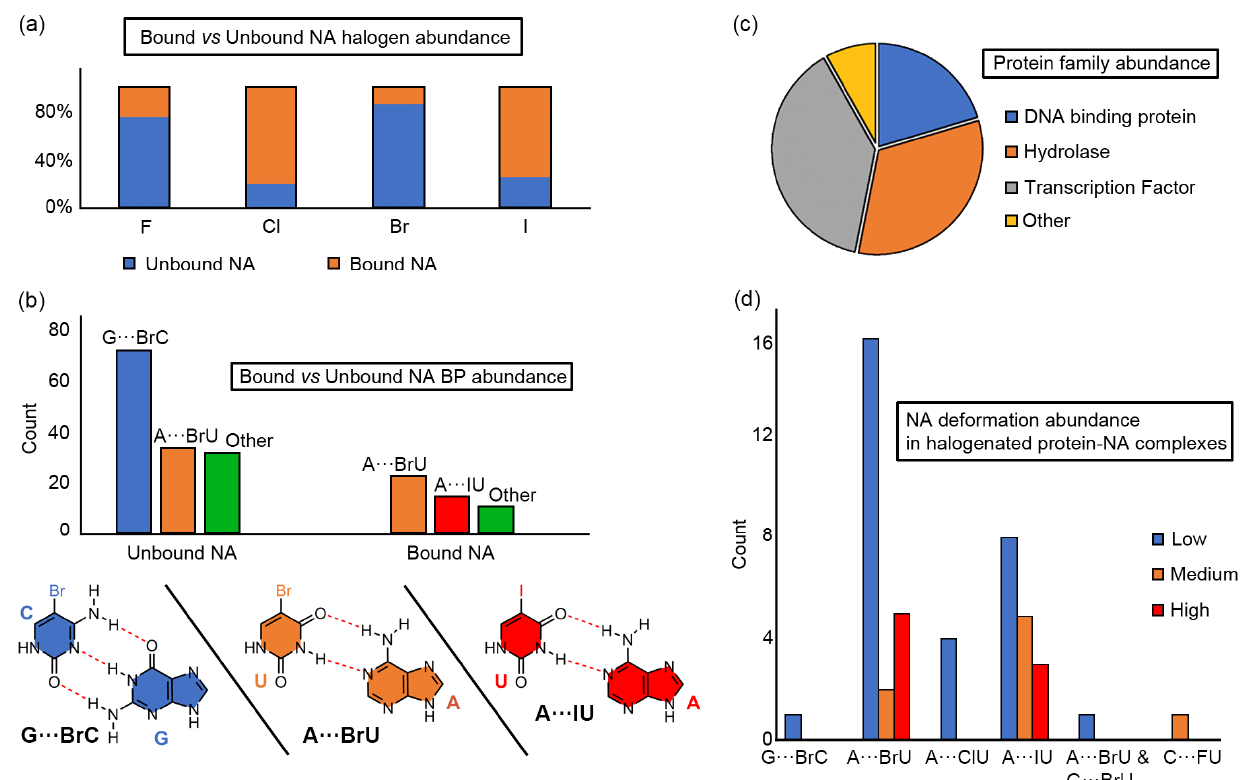
Figure 1. Statistical results from the PDB survey. ( a ) Bound vs. unbound NA halogen abundance, ( b ) bound vs. unbound (to a protein) NA BP abundance, ( c ) protein family abundance, and ( d ) NA deformation abundance in halogenated protein-NA complexes.